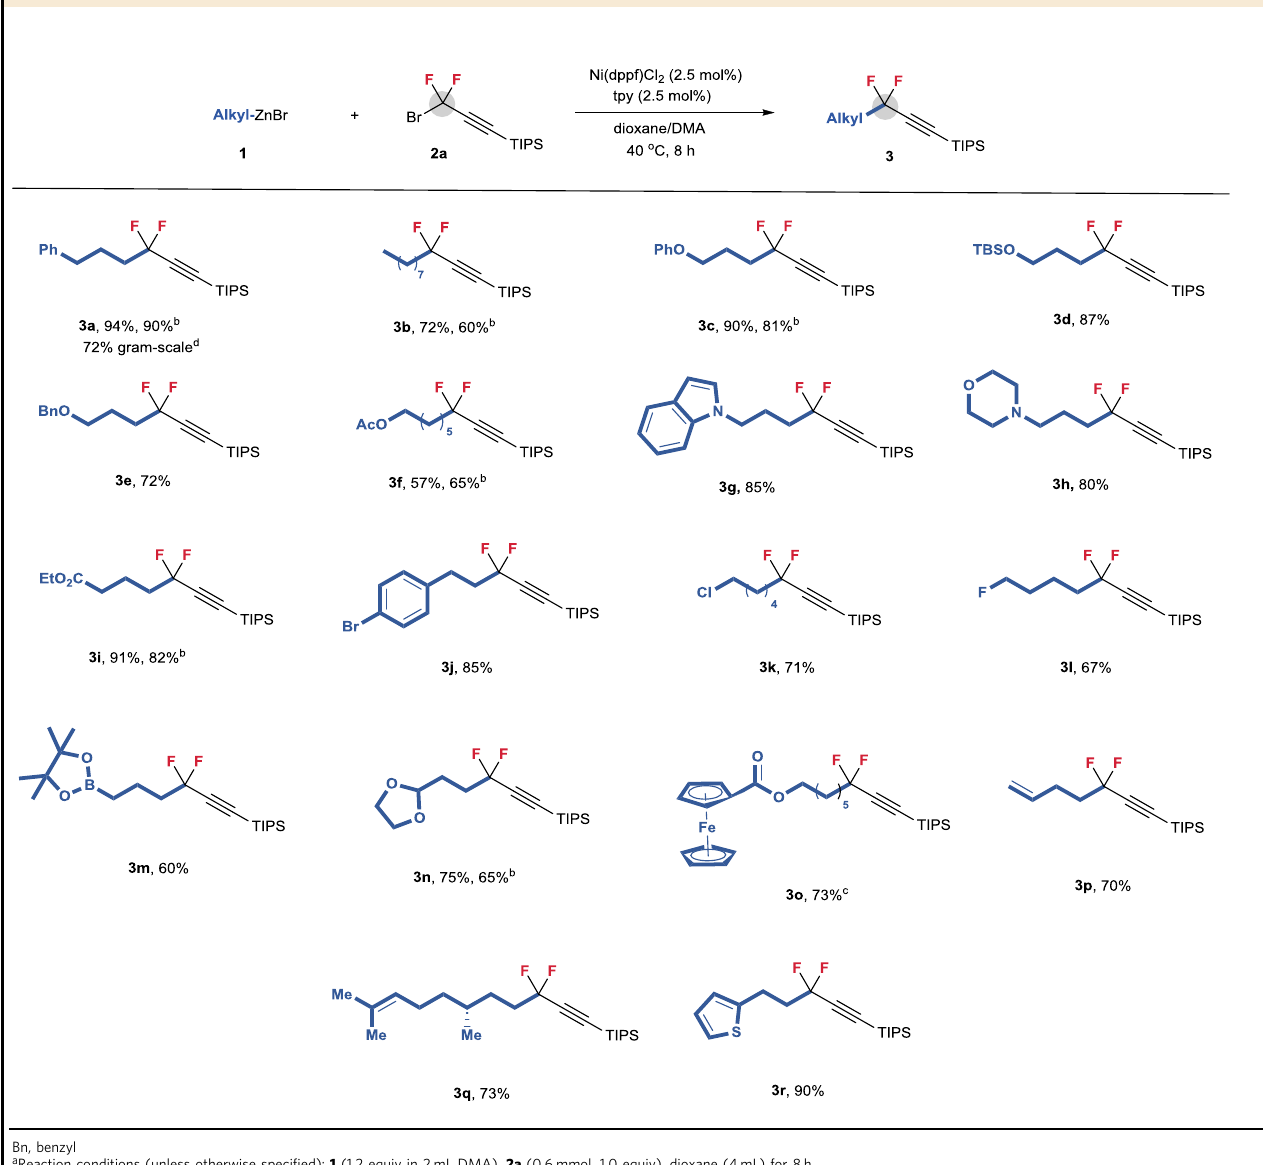
Table 2 Ni-catalyzed cross-coupling of unactivated alkylzincs 1 with 2a